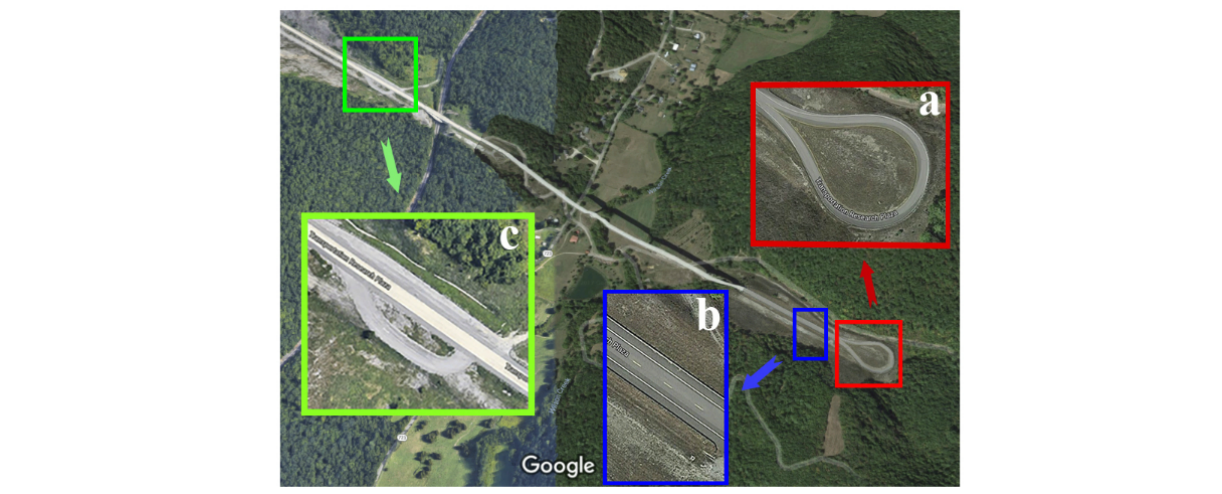
Figure 2. Virginia Smart Road: a) roundabout used for cornering; b) straight portion of the road used for braking and acceleration; c) turnout lane used for turning left and